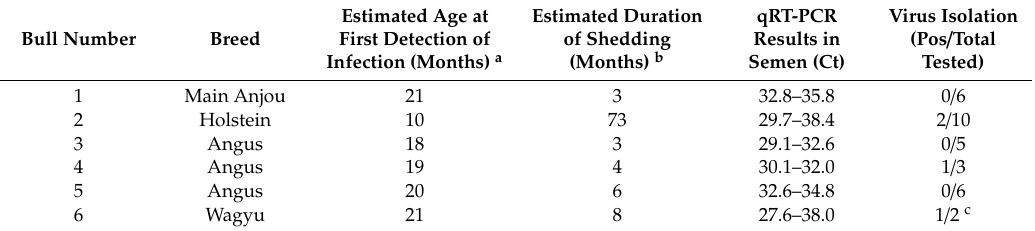
Table 1. Summary of details for bulls